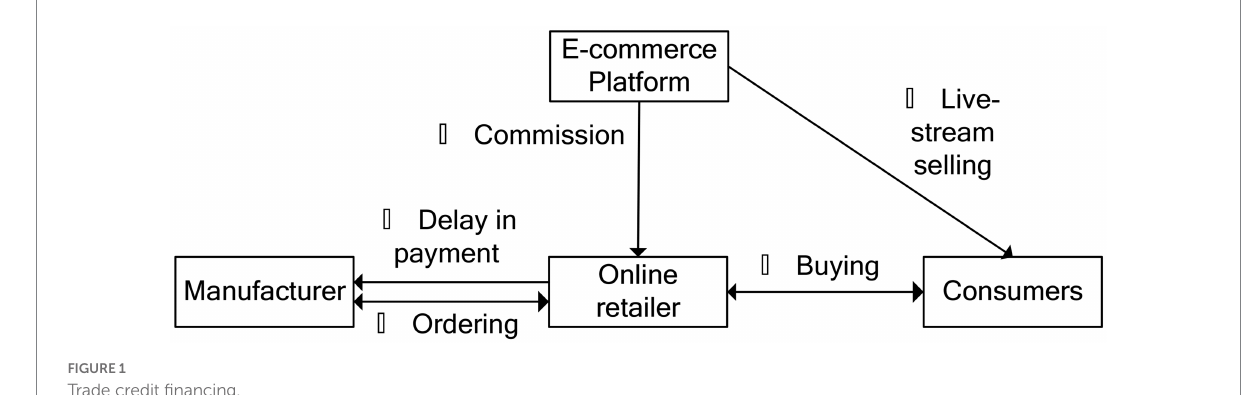
FIGURE 1 Trade credit